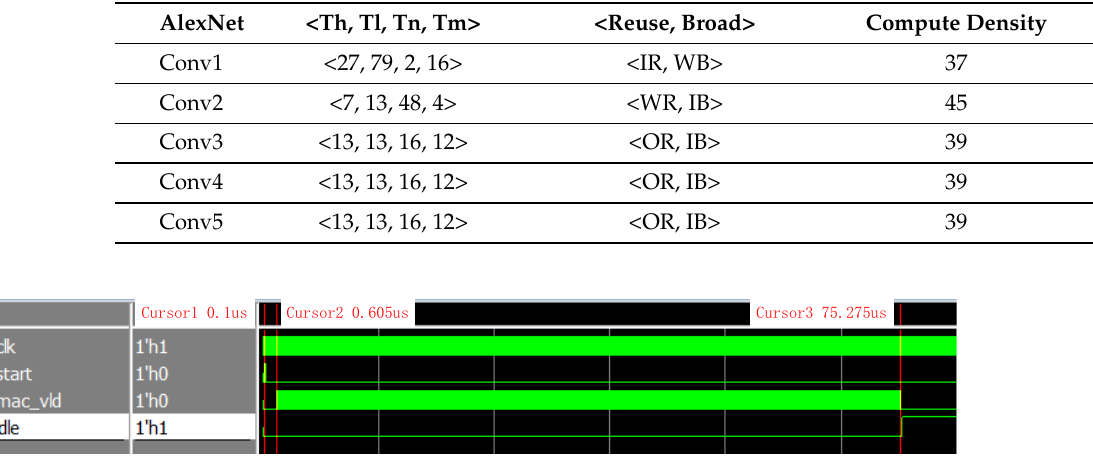
Table 8. The scheduling scheme of AlexNet Conv layers.